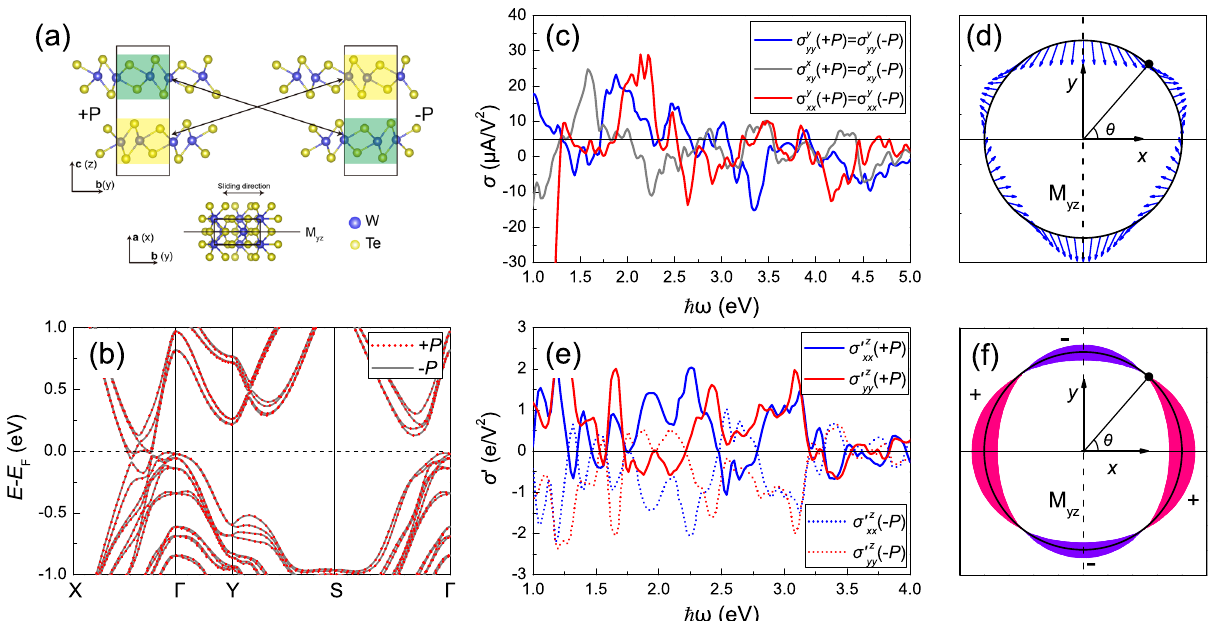
Fig. 3 Calculated results of ferroelectric bilayer WTe 2 . a Crystal structure. + P and – P states are adopted from ref. 43 . Rectangle in a represents the unit cell, and the double-arrows line means the monolayer transformation under b M xy symmetry. The lower panel in a denotes the top view of bilayer WTe 2 with + P state. b Band structures of + P and – P states. c In-plane and e out-of-plane BPVE coef fi cients. d In-plane BPVE photocurrent and f out-of-plane BPVE polarization of the + P states with the different directions of polarization of light. The length of arrows in d indicates the magnitude of in-plane BPVE response (in arbitrary unit), where σ x of the ribbon in f denote the magnitude and direction of out-of-plane BPVE response, and σ 0 z